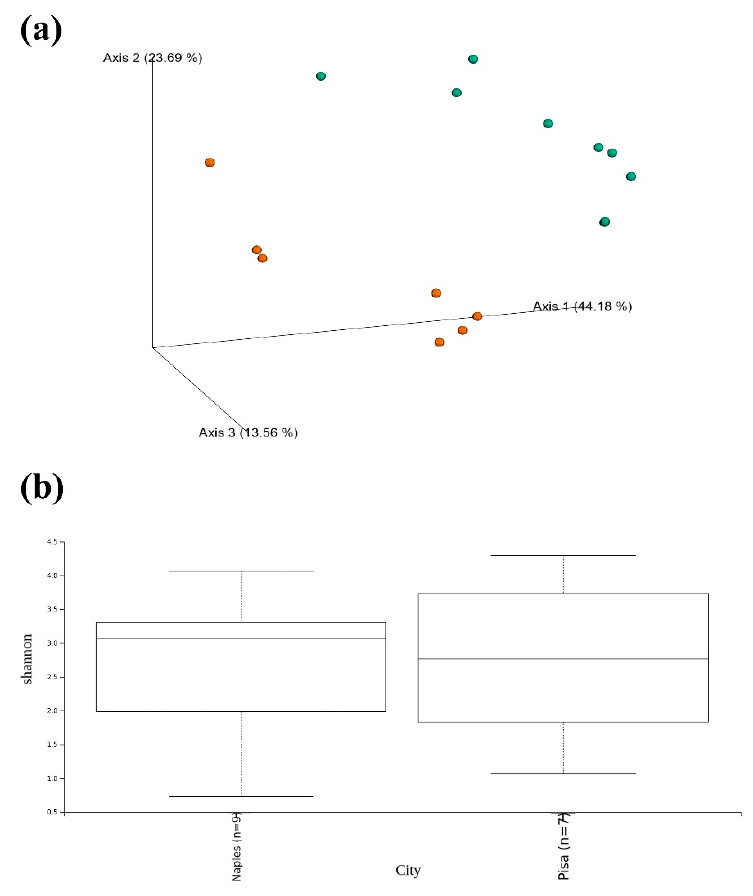
Figure 4. Diversity measures of ITS2 sequencing data. ( a ) Beta diversity represented by Principle Coordinate Analysis Emperor plot on a Bray–Curtis distance matrix. Green dots: Naples, orange dots: Pisa. ( b ) Boxplots of Alpha-diversity Index (calculated as Shannon index) in the two archaeological sites.